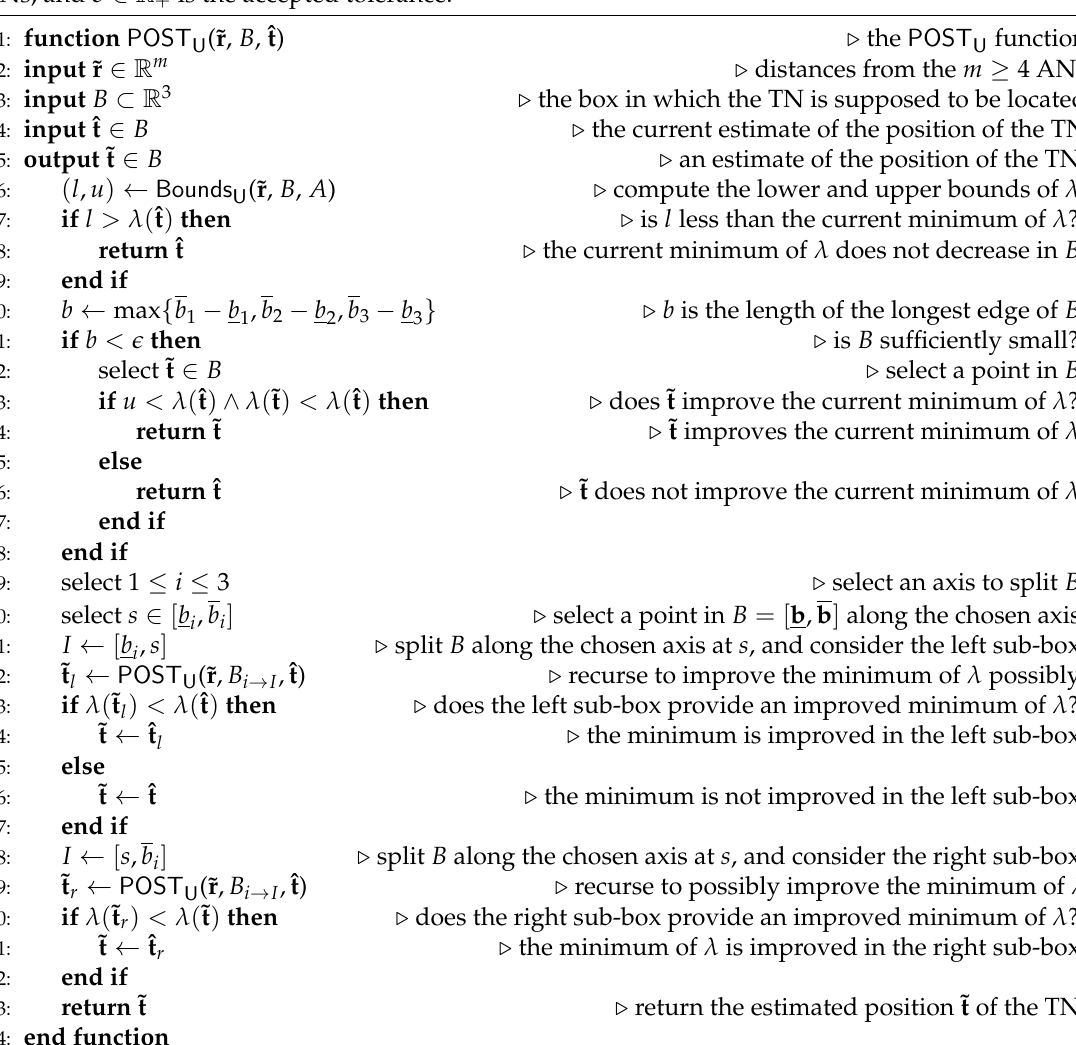
Algorithm 1 Pseudocode of the POST U function, which is used to estimate the position ˜t ∈ B of the TN in box B = [ b , b ] ⊂ R 3 using estimated distances ˜r ∈ R m from m ≥ 4 ANs together with an initial approximation ˆt of the position of the TN. The m × 3 anchor matrix A contains the positions of the ANs, and (cid:101) ∈ R + is the accepted